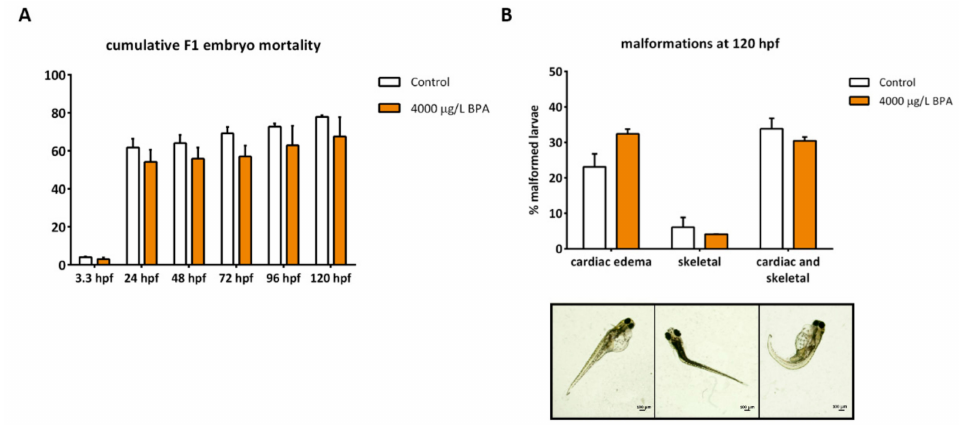
Figure 5. Evaluation of F1 embryonic development. ( A ) cumulative percentage of embryo mortality from 3.3 to 120 hpf of six independent matings per treatment ( n = 6). ( B ) percentage of malformed larvae at 120 hpf of six independent batches per treatment ( n = 6). No significant di ff erences between treatments ( p < 0.05) were found. Images represent the main type of malformations: cardiac edema, skeletal and altogether; scale bar 100 µ